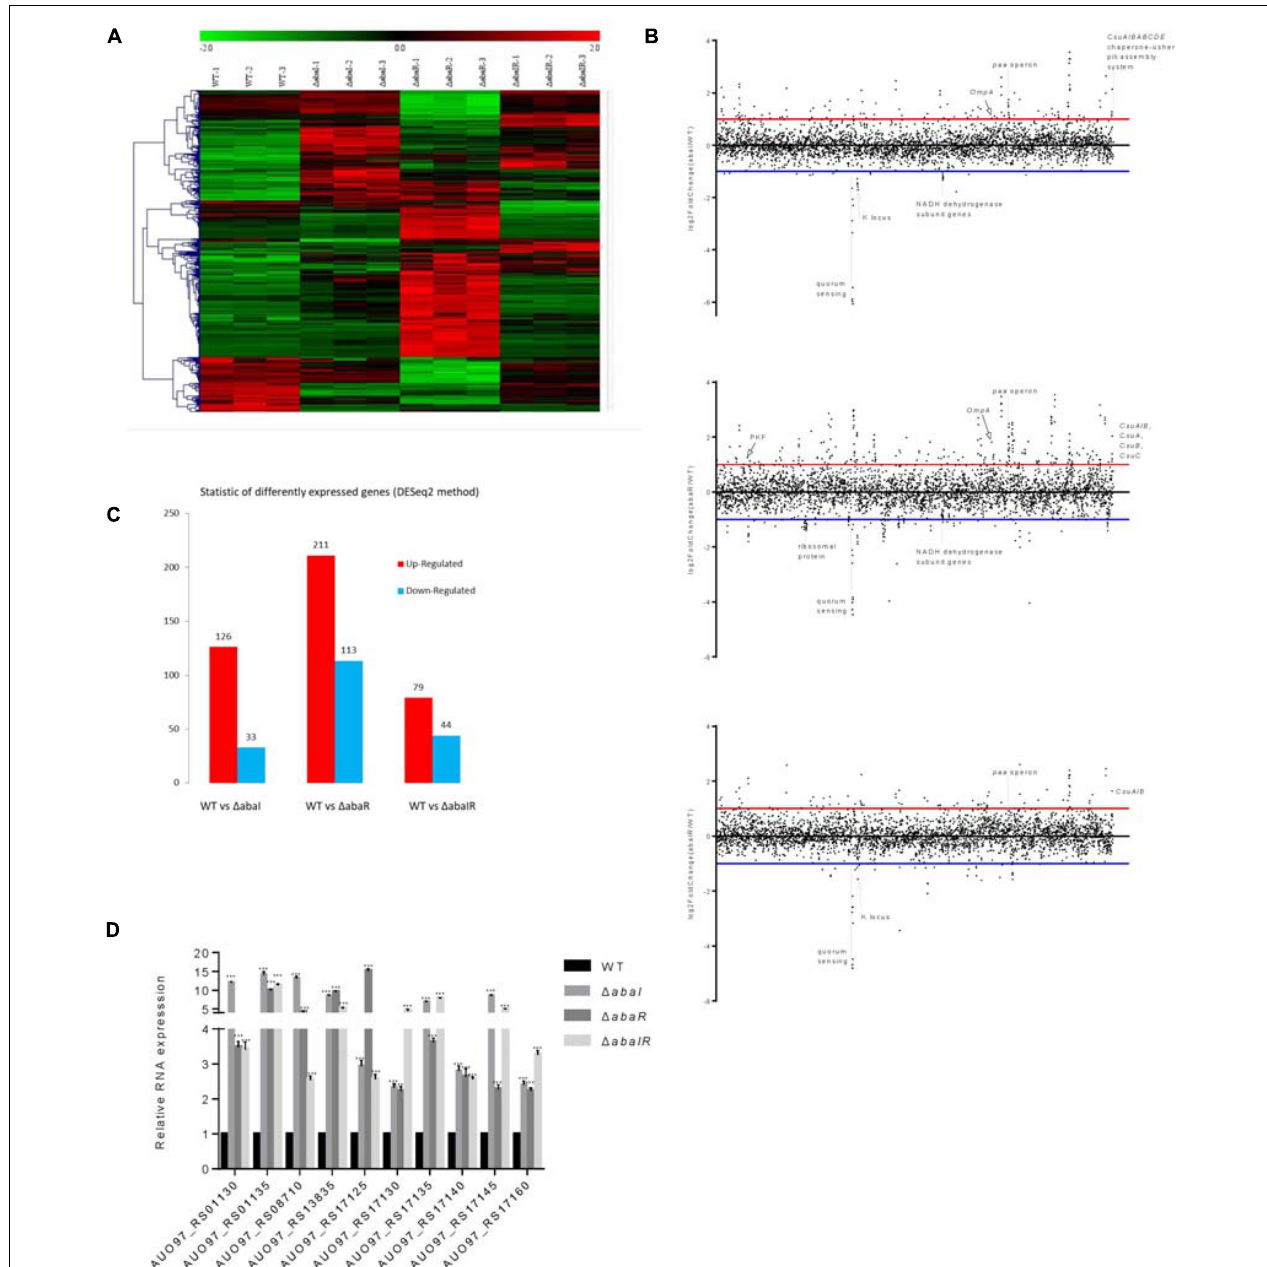
FIGURE 7 | (A) Heat map representation and hierarchical clustering of gene expression changes. The x -coordinate represents the different experimental groups. Data represent differential gene expression profiles (PFKM) for genes listed along the ordinate. Red indicates increased expression, and green indicates decreased expression; color intensity indicates the magnitude of difference in expression according to the horizontal scale at the top. Black depicts genes with no significant difference in expression. (B) The genome-wide transcriptomic profile, genome-wide differential gene expression locus map, and plot of differential gene expression mutant compared with WT with respect to the gene locus tag number. (C) The vertical axis represents the number of significantly DEGs. The log2-fold change in expression for each gene meeting the study threshold (log2-fold change > 1, false discovery rate < 0.001). The number of significantly DEGs can be divided into the number of significantly upregulated DEGs and the number of significantly downregulated DEGs. (D) Relative expression of 10 upregulated genes; results are presented relative to WT, which was normalized to 1. The results are expressed as mean ± SEM for at least three biological replicates. *** P < 0.001, t -test.